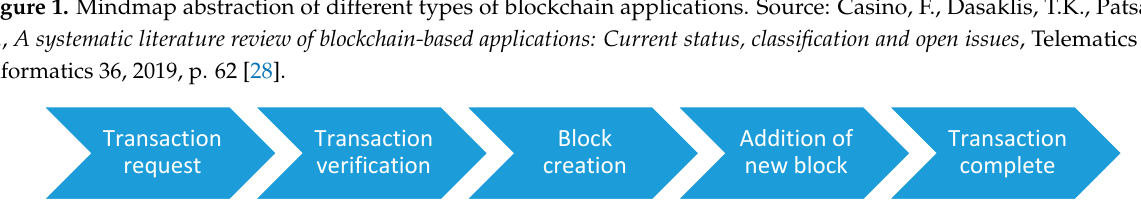
Figure 1. Mindmap abstraction of different types of blockchain applications. Source: Casino, F., Dasaklis, T.K., Patsakis,